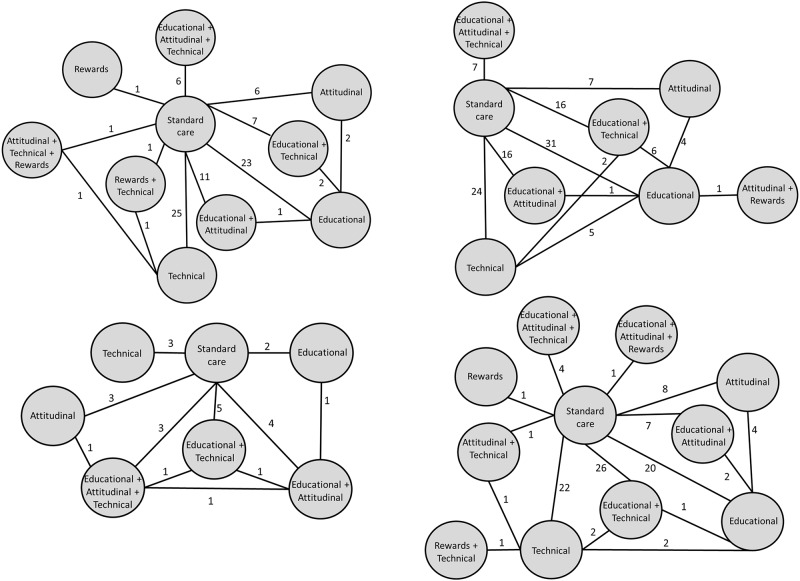
Networks of the comparisons between interventions for each time period (0–3 months, 4–6 months, 7–9 months, ≥10 months) considering the overall composite measure of adherence.Each node represents an intervention. Directly comparable interventions are linked with a line, the number of trials for each comparison are shown in each line.